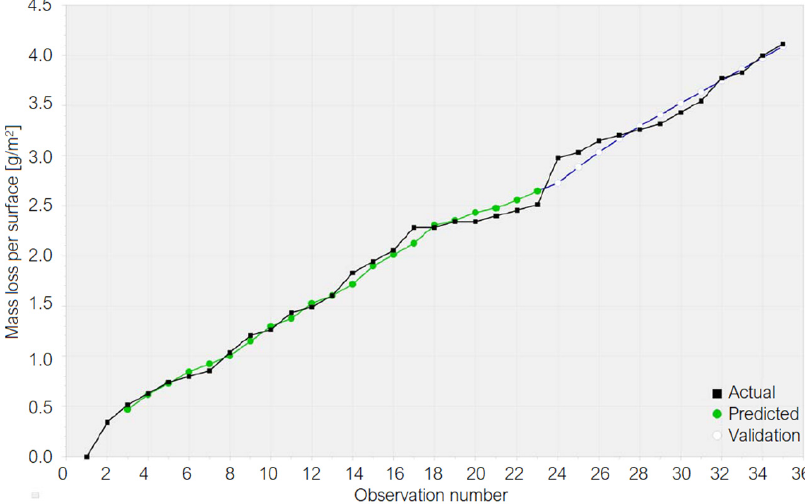
Figure 8. The series of the recorded values (called “Actual”), values computed in the Training procedure (called “Predicted”), and those calculated in the Test procedure (called “Validation”) in the GRNN model for the Cu sample.